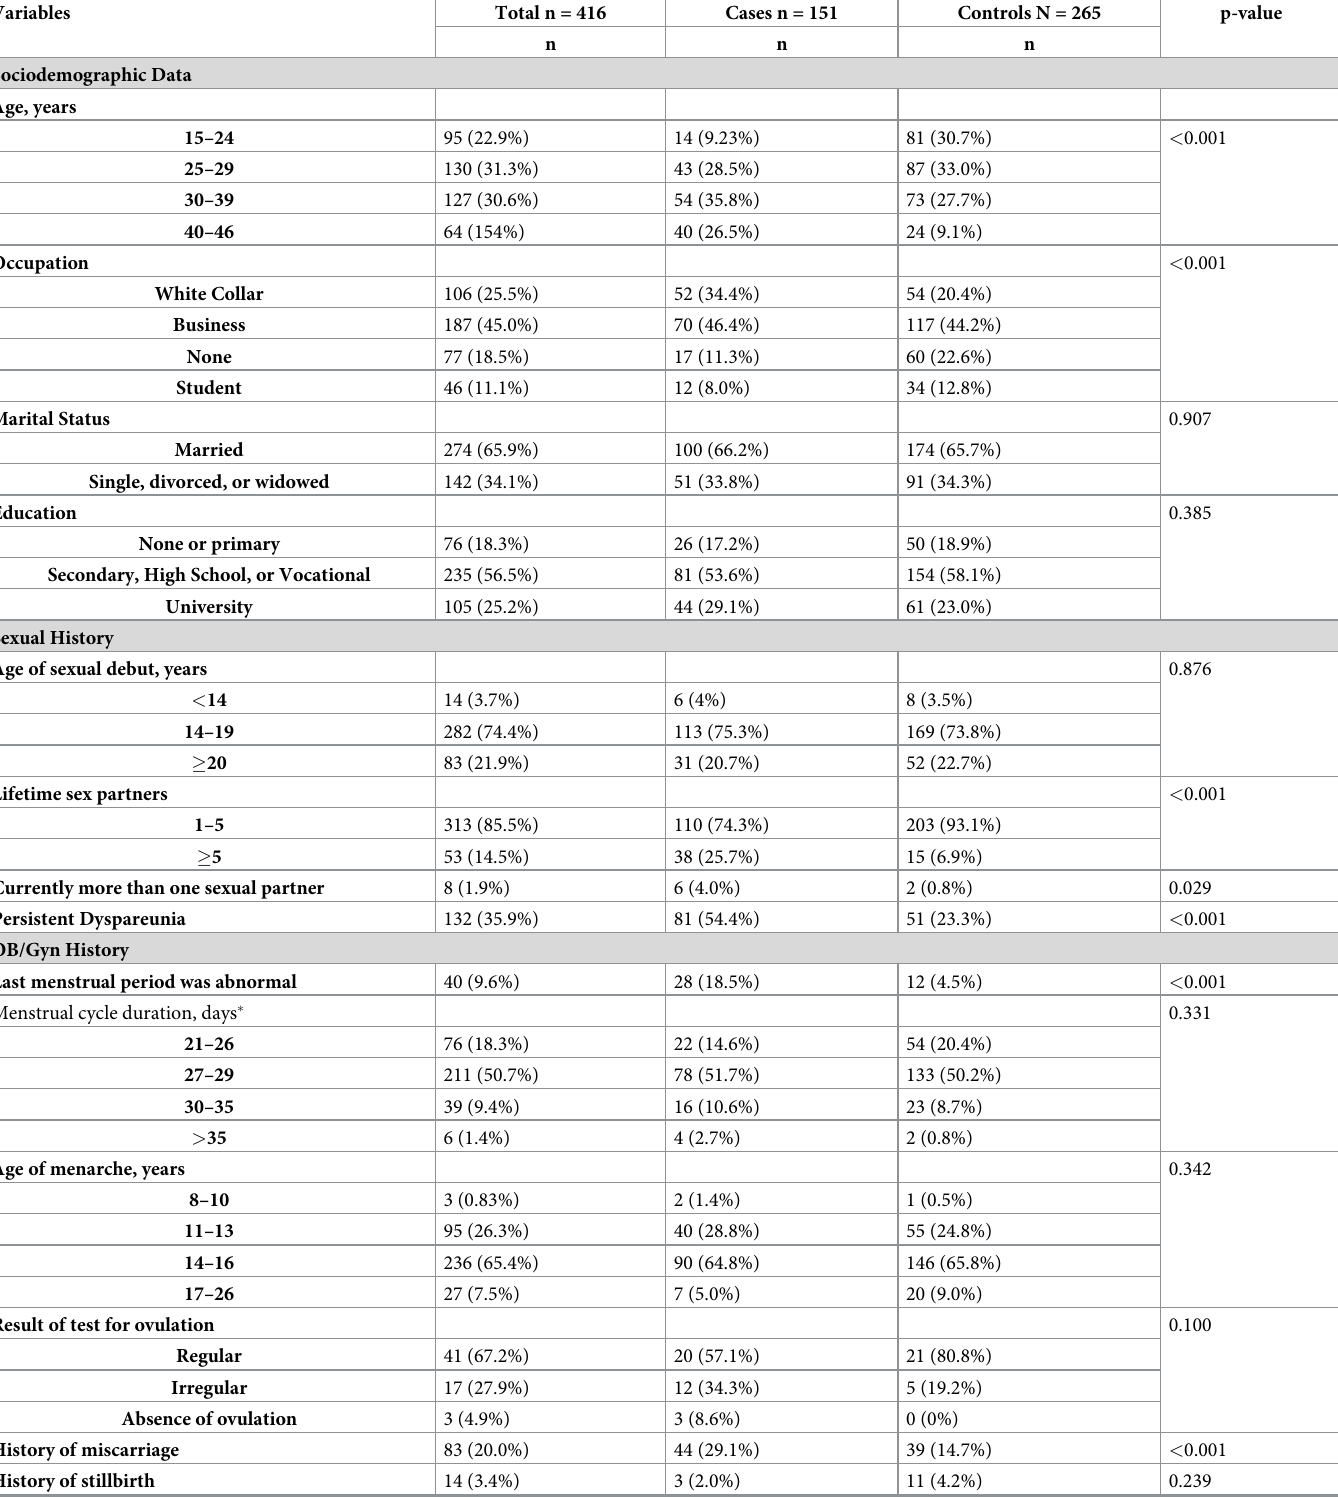
Table 1. Participant characteristics for women with secondary infertility (cases) and pregnant women